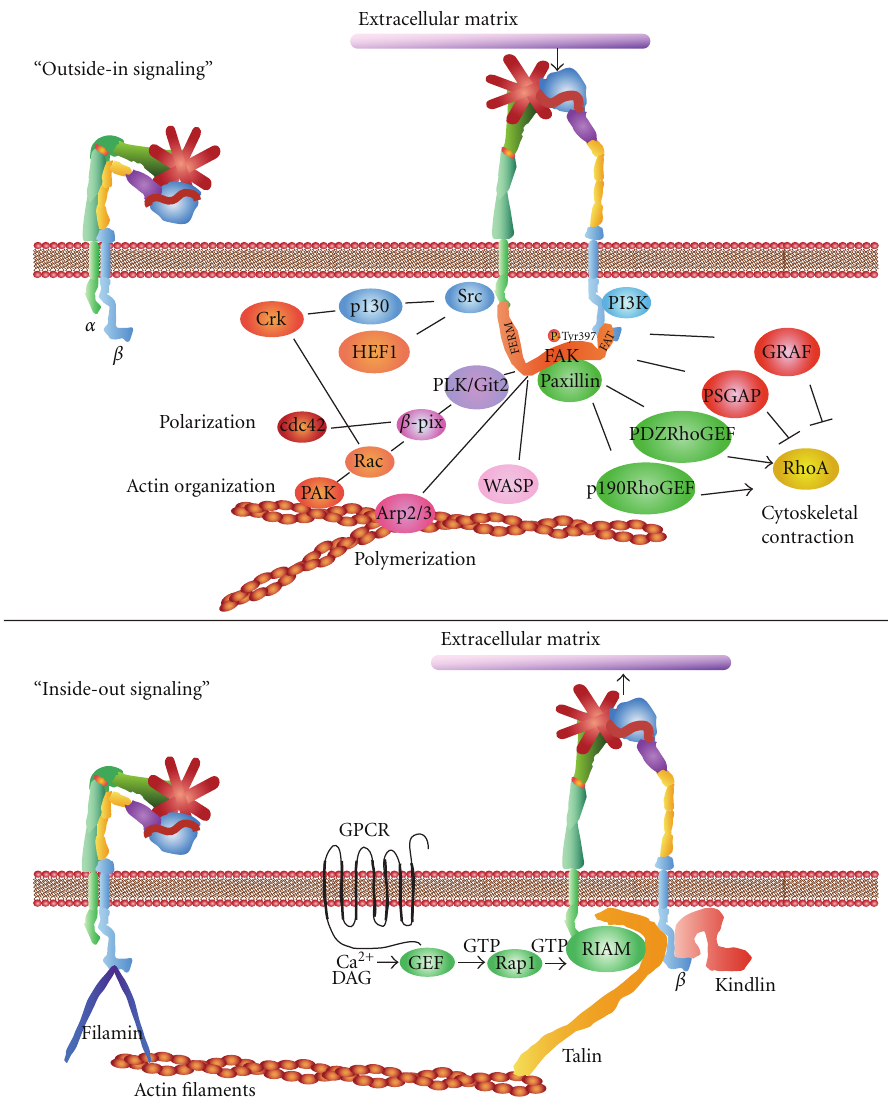
Figure 5: “Outside-in” and “Inside-out” signaling. The “outside-in” binding of ECM ligands to cell surface integrins stimulates conformational changes that activate focal adhesion kinase (FAK). FAK then is autophosphorylated on Tyrosine 397 near the catalytic domain, which binds Src. FAK contains a central kinase domain bordered by FERM (protein 4.1, ezrin, radixin, and moesin homology) domain at the N-terminus and a focal adhesion targeting (FAT) sequence at the C-terminus. Activated Src interacts with human enhancer of filamentation1 (HEF1) and p130 CRK-associated substrate (p130CAS) sca ff old proteins that help to positively regulate Src-FAK-Crk interactions with Rac. FAK also activates (PKL/Git2)- β -Pix complexes and β -pix then serves either as an exchange factor for Cdc42 or a sca ff old protein to promote signaling via Rac and p21-activated protein kinases (PAK). FAK also interacts with actin-related proteins (ARP2 and ARP3) which is regulated by the Wiskott-Aldrich Syndrome Protein (WASP). ARP2/ARP3 initiates the polymerization of new actin filaments. FAK also influences actin contraction and polarization through another GTPase protein, Rho. The regulation of Rho GTPase hydrolysis of GTP (active) to GDP (inactive) form occurs through the opposing activities of guanine nucleotide exchange factor (GEFs). GTPase regulator associated with FAK (GRAF) and p190RhoGAP blocks actin cytoskeleton changes. In contrast, PDZRhoGEF and p190RhoGEF both serve to activate Rho. “Outside-in signaling” transfers integrin-mediated external signals to the inside of cells.“Inside-out signaling” depends on talin and kindlin. Both talin and kindlin contain FERM (4.1/ezrin/radixin/moesin) domains and a highly conserved C-terminal F3 domains. Talins bind β integrin, actin through the C-terminus, and also vinculin. Kindlins bind integrins, the cell membrane, and various actin adaptor proteins like migfilin, or integrin-linked kinase (ILK). Talin activation occurs through G-protein-coupled receptors that increases cytoplasmic Ca 2+ and diacylglycerol. This activates GEF function in conjunction with Ras-proximate-1/Ras-related-protein-1- (Rap1-) GTPase. Rap1 then binds to Rap1-GTP-interacting adaptor molecule (RIAM). RIAM recruits talin to the membrane and the α and β integrin cytoplasmic domains. Kindlin interacts with β integrin cytoplasmic domain stabilizing the activated state of the integrin complex. “Inside-out signaling” strengthens adhesive contacts and the appropriate force necessary for integrin-mediated cell migration, invasion, ECM remodeling, and matrix